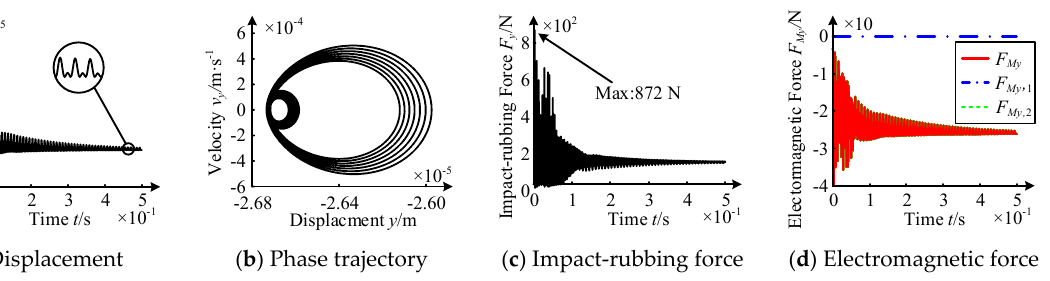
tends to converge. The variation of the impact-rubbing force/electromagnetic force is sim- Figure 13. Operating law under upper unit failure. ilar to that of the displacement, respectively converging at about 126 N and − 26 N, and